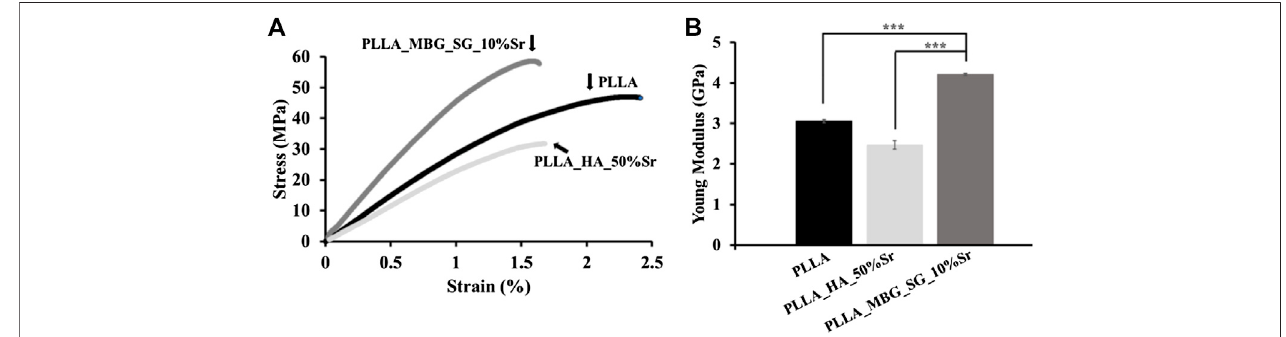
FIGURE 6 | Tensile properties of the extruded fi laments. (A) Stress-strain curves; (B) Young Modulus. The results are expressed as mean ± SD, *** p < 0.001.